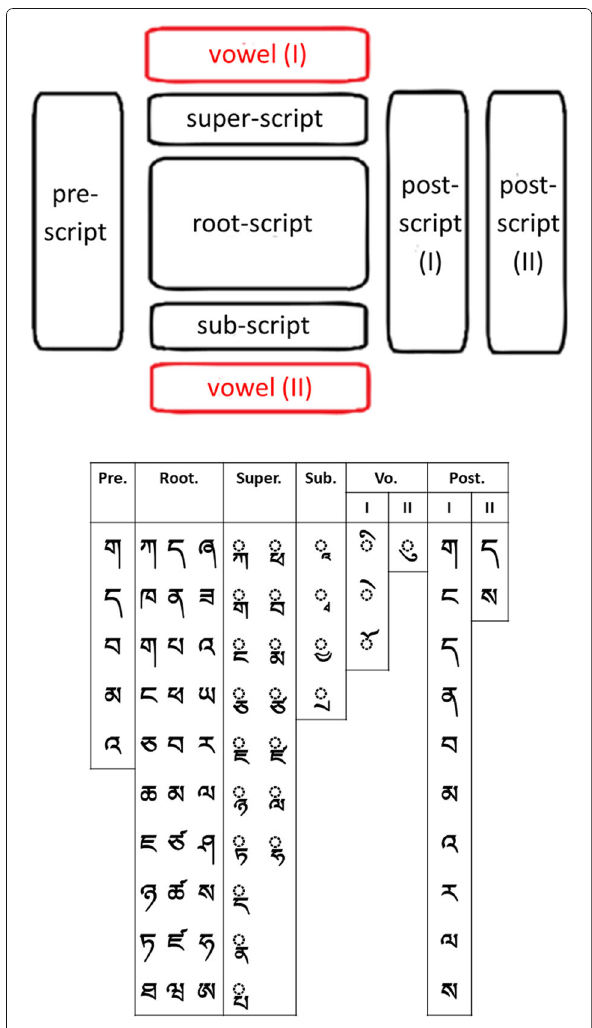
Fig. 2 The structure of a character in the Tibetan writing systems